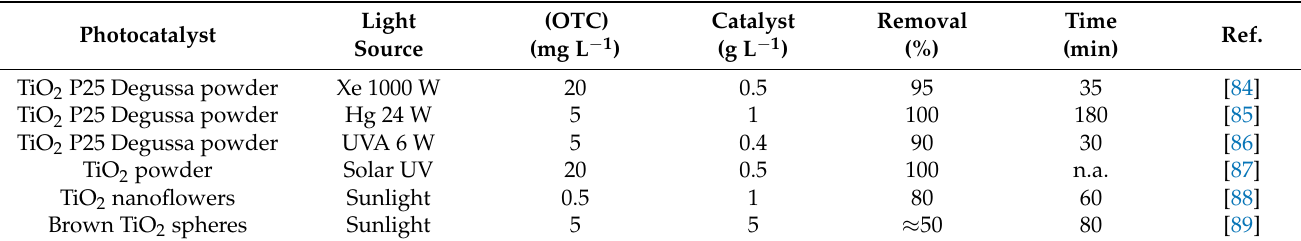
Table 1. OTC photodegradation over pure TiO 2 photocatalyst.